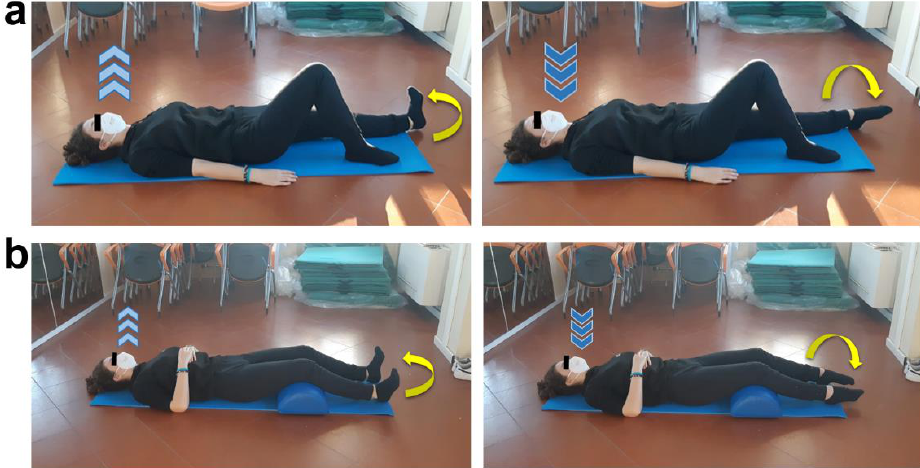
Figure 2. Tibialis anterior strengthening exercises. ( a ) Supine position, resting leg flexed and working one extended, arms laying by body sides with hand palms down. Inhale, exhale (light blue arrows) while performing a dorsiflexion of the straight leg foot (pointing up yellow curved arrow), and then inhale (dark blue arrows) while performing a plantar flexion of the same foot (pointing down yellow curved arrow). Three sets of ten total movements (dorsi/plantar flexion) for each foot, 30 s of recovery. ( b ) Supine position, rest popliteal fossa of both legs on a semi-cylindrical cushion, bend arms and place hands on chest. Inhale, exhale (light blue arrows) while performing a dorsiflexion of both feet (pointing up yellow curved arrow), and then inhale (dark blue arrows) while performing a plantar flexion (pointing down yellow curved arrow). Three sets of one minute and a half each, 20 s of recovery.